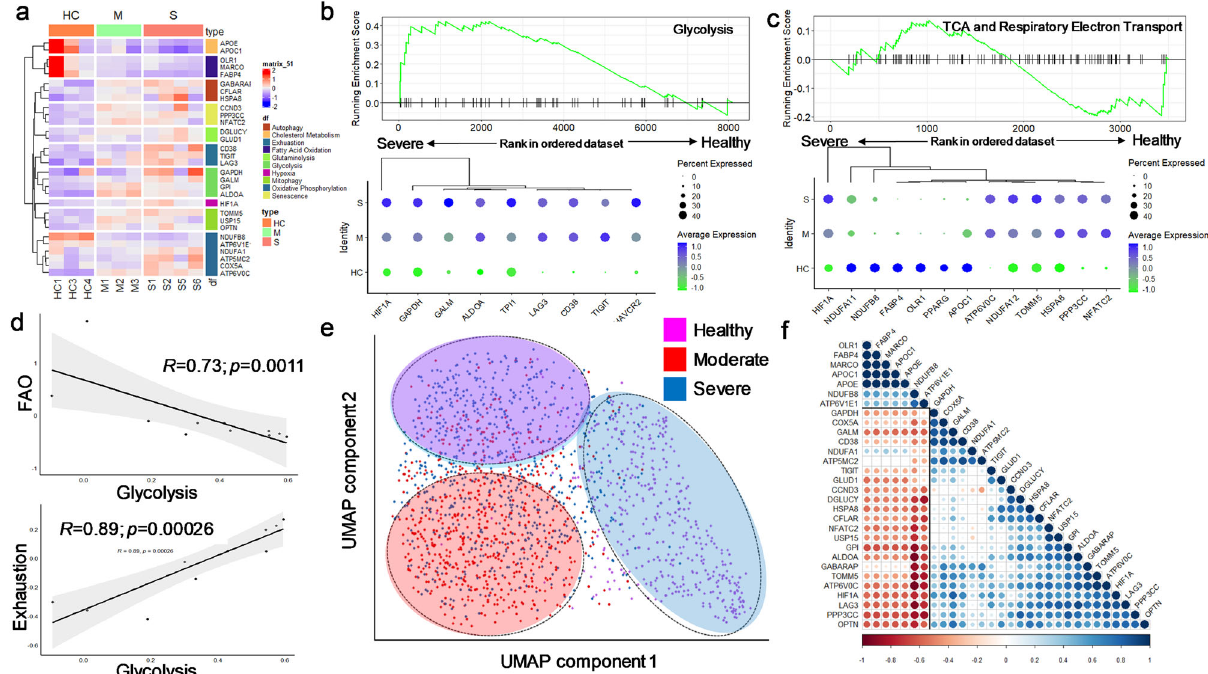
Fig. 7 Metabolic reprogramming in BALF CD8 + T M during SARS-CoV-2 infection. a Heatmap displaying the expression of key metabolic genes of CD8 + T M . b – c GSEA enrichment and hierarchical clustering plot for glycolysis ( b ) and TCA and Respiratory Electron Transport ( c ) to compare severe COVID-19 vs. healthy patients. d Linear regression and Pearson correlation analysis between module scores for glycolysis and exhaustion or FAO. e UMAP projection of CD8 + T M clustered on 42 differentially expressed metabolic genes, circles were manually drawn to highlight clustering f . Pearson matrix showing a correlation between differentially expressed